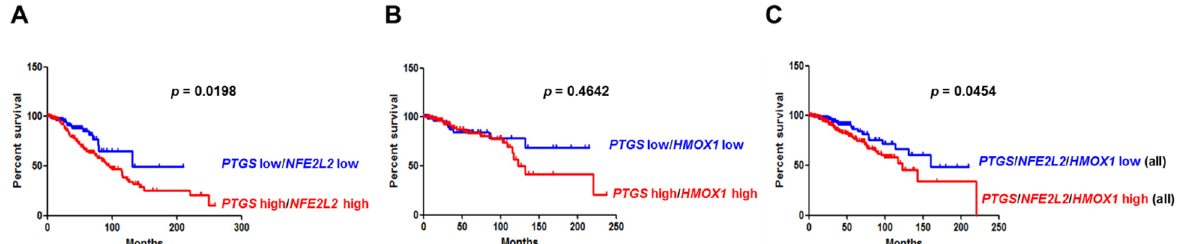
Figure 7. Elevated coexpression of genes encoding COX-2 and NRF2 or COX-2, NRF2 and HO-1 is associated with poor clinical outcomes. ( A ) Analysis of both PTGS2 and NFE2L2 expression showed breast cancer-specific survival (low expression of both PTGS2 and NFE2L2 , n = 142; high expression of both COX-2 and NFE2L2 , n = 178) from public The Cancer Genome Atlas (TCGA) data sets. ( B ) Analysis of gene encoding both COX-2 and HO-1 in relation to breast cancer-specific survival (low expression of both PTGS2 and HMOX1 , n = 96; high expression of both PTGS2 and HMOX1 , n = 109) from public TCGA data sets. ( C ) Analysis of all three PTGS2, NFE2L2 , and HMOX1 expression showed breast cancer-specific survival (low expression of all three PTGS2, NFE2L2 , and HMOX1 , n = 46; and high expression of all three PTGS2, NFE2L2 , and HMOX1 , n = 90) from public TCGA data sets. PTGS2 , NFE2L2 , and HMOX1 denote human genes that encode COX-2, NRF2, and HO-1, respectively.